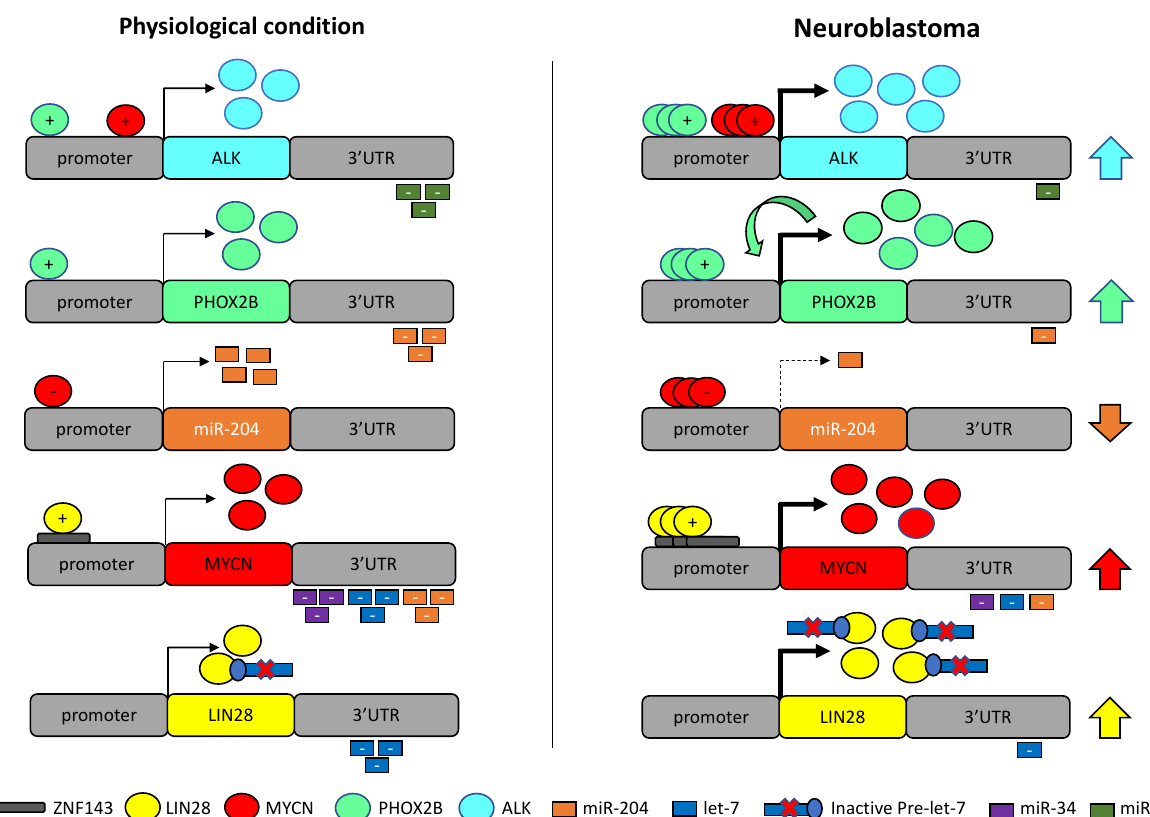
Figure 5. Transcriptional and post-transcriptional relationships between ALK, PHOX2B, MYCN, LIN28, miR-204, mir-34 and let-7. Genes are schematically represented by colored coding regions inserted between grey upstream (promoter) and downstream (3 (cid:48) UTR) regulatory regions. For each gene, transcription factors (circles) acting on its promoter and/or microRNAs (rectangles) acting on the 3 (cid:48) UTR, are shown in both physiological ( left ) and neuroblastoma ( right ) conditions. Thick or dashed arrows indicate an increased or decreased level of expression, respectively, of the gene in NB with respect to the physiological corresponding condition, in which gene expression level is represented by thin arrows. The protein products for each gene are shown as circles painted like the corresponding gene. The number of circles/rectangles represents the amount of product reflecting these levels of gene expression. Activation or inhibition effects of TFs are represented by “+” or “ − “, respectively, within the circles on the promoter regions. In NB condition, the colored up and down arrows on the right indicate the resulting protein expression levels for each gene.